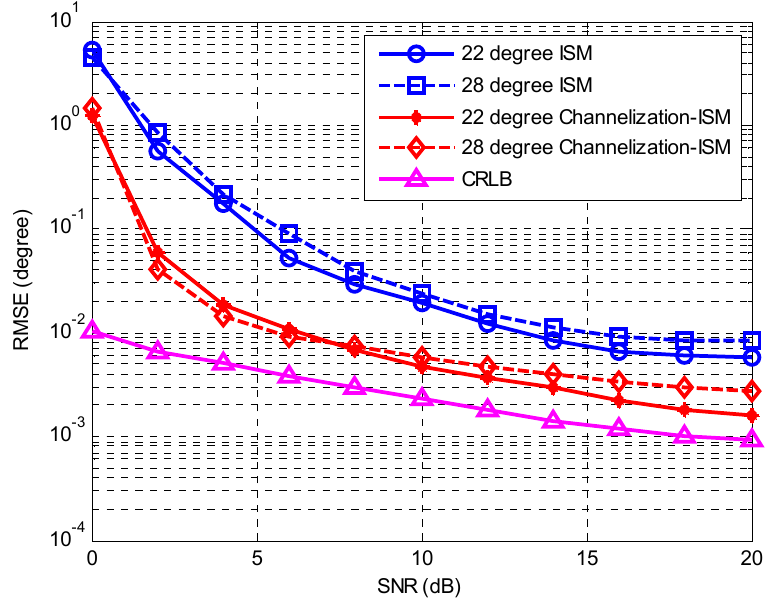
Figure 4. RMSE of the DOA estimates against the SNR. Figure 3. RMSE of the DOA estimates against the SNR. Figure 3. RMSE of the DOA estimates against the SNR.